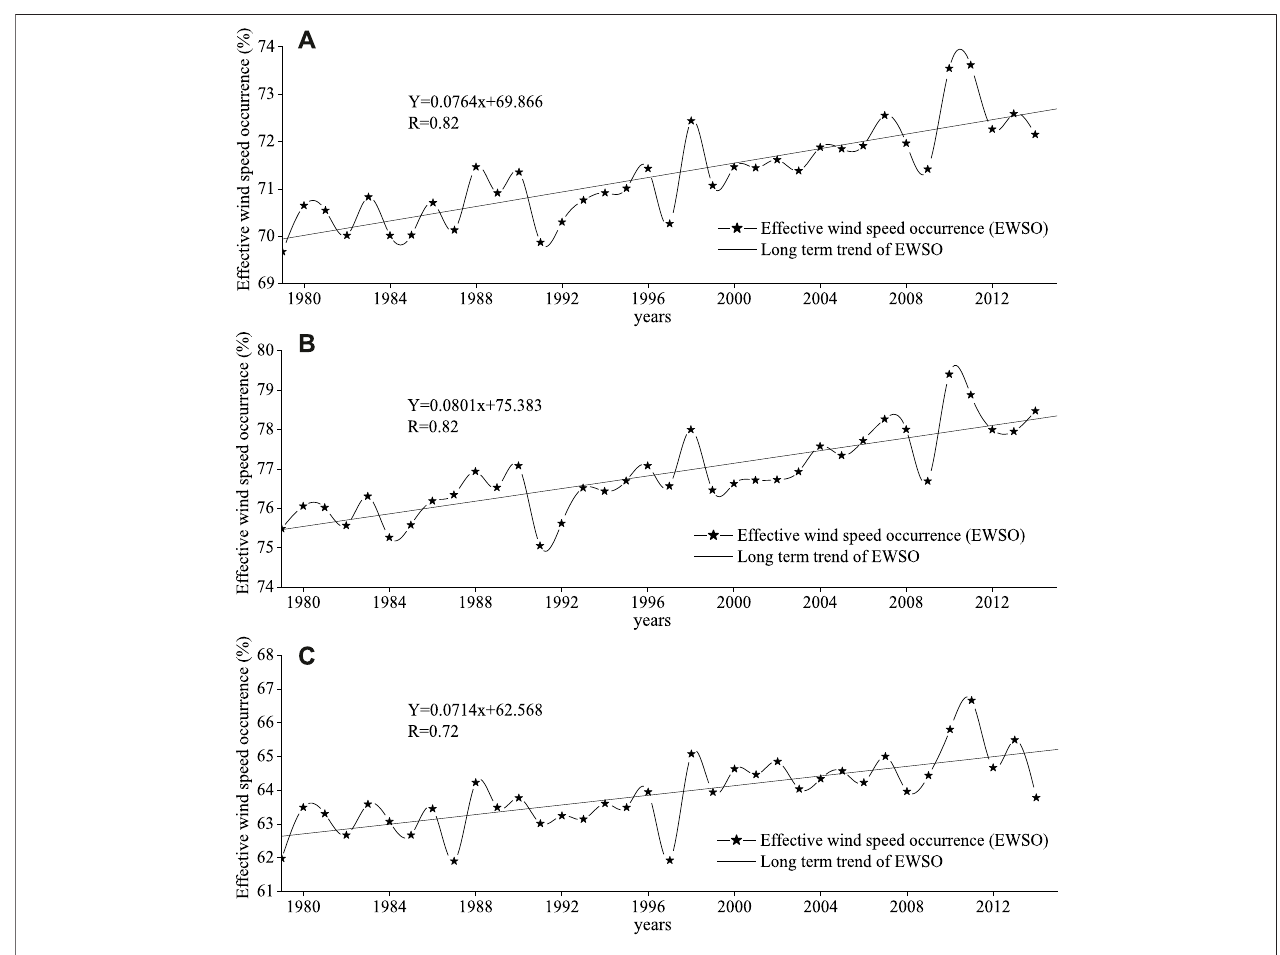
FIGURE 3 | Annual effective wind speed occurrence in the global ocean (A) , south global ocean (B) , and the north globalocean (C) for the period 1979 – 2014 and the long-term trends.